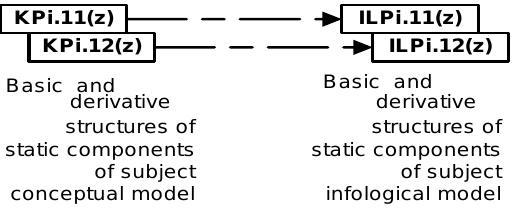
Fig. 2. The mapping structure of the static components of semantic and syntactic models